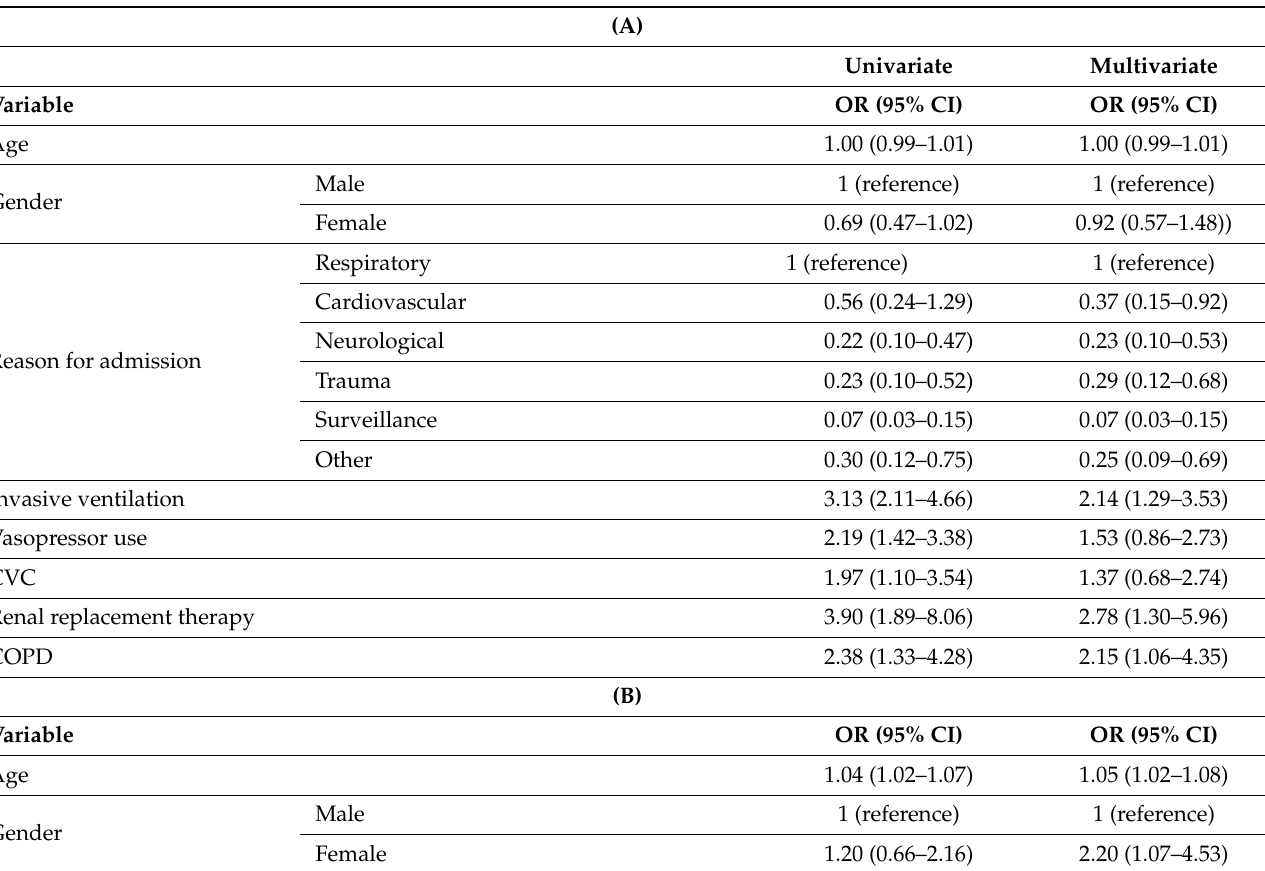
Figure 1. Site of infection and isolated microorganism. ( A ). Infection sites in infected patients ( N = 184). ( B ). Isolated microorganisms in culture-positive patients ( N = 114). Percentages can exceed 100% because patients could have more than one infection. Table 4. ( A ) Univariate and multivariable logistic regression analysis with infection as the dependent variable. ( B ) Univariate and multivariable logistic regression analysis with mortality at 60 days as the dependent